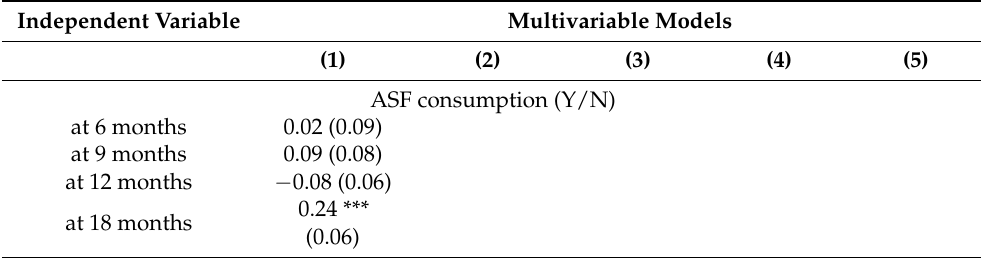
Table 4. Association of total HCZ scores and ASF